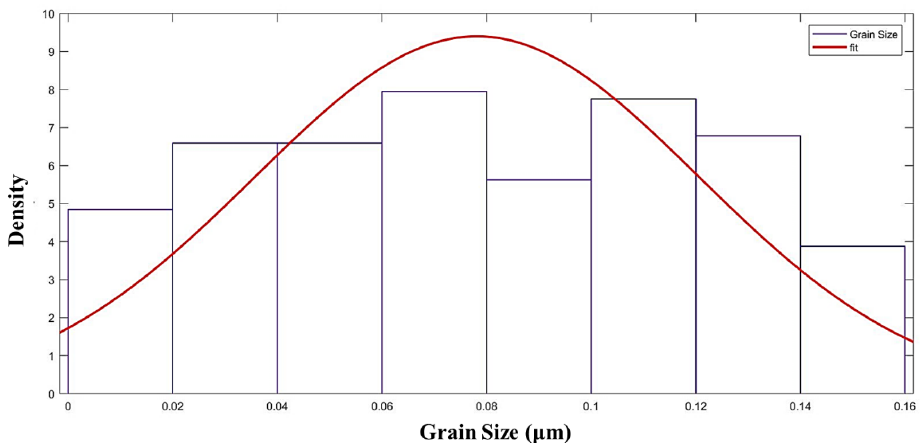
Figure A2. Density plot of grain size of 316l SS sample. Bioengineering 2019 , 6 , x FOR PEER REVIEW